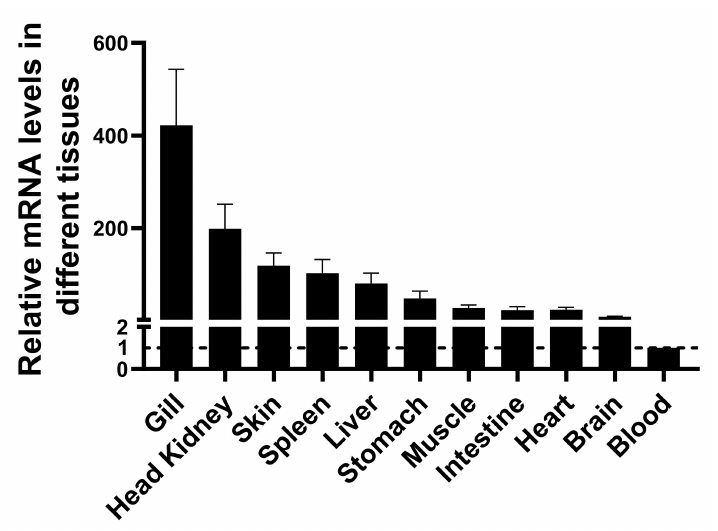
Figure 4. Tissue expression profile of Lc IgT. The expression levels of the Lc IgT gene in eleven tissues of healthy large yellow croaker (liver, heart, head kidney, gills, brain, spleen, stomach, intestine, skin, muscle, and blood) were detected by real time-PCR. Total RNA from various tissues of five fish was isolated and then transcribed into the first cDNA. Error bars represent the mean ± standard error of the mean (mean ± SEM).